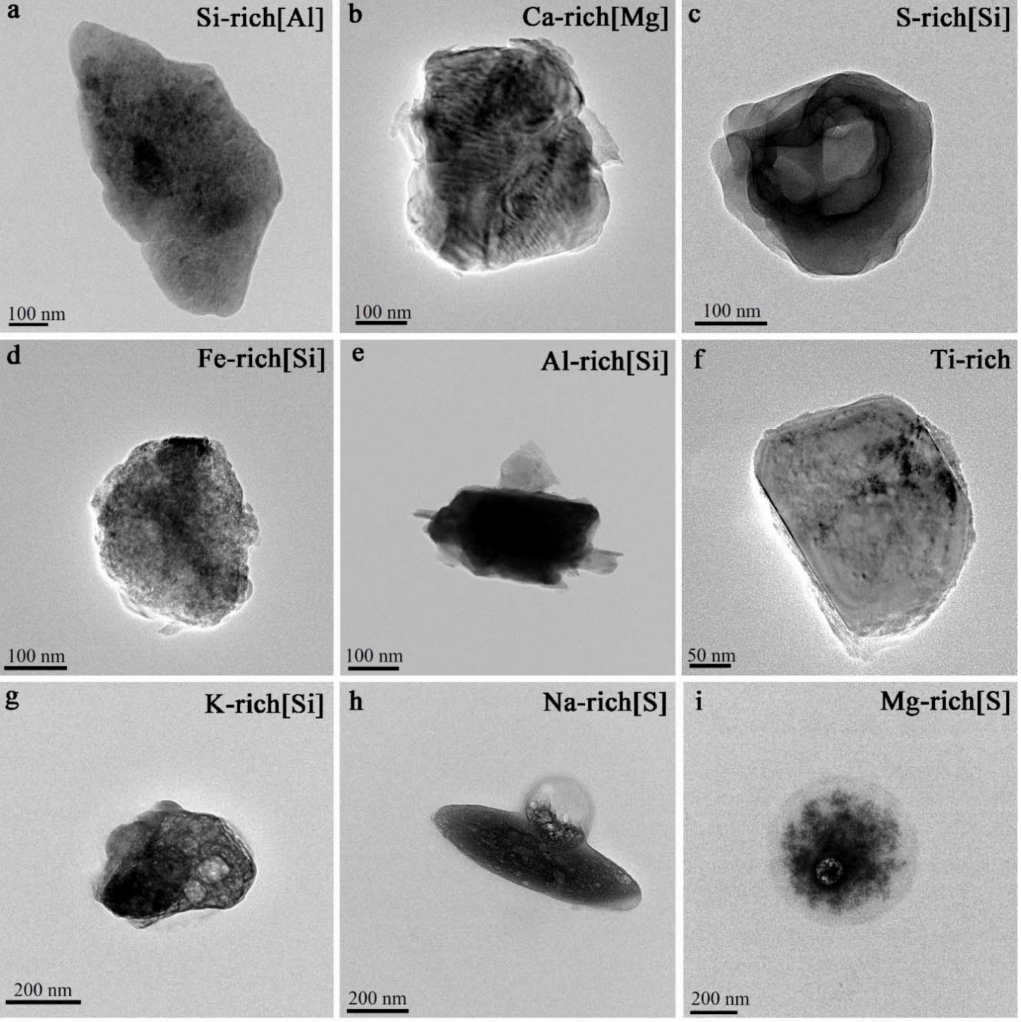
Figure 2. The morphology and types of mineral particles collected during different stages of the dust storm. The elements in square brackets represent the second highest